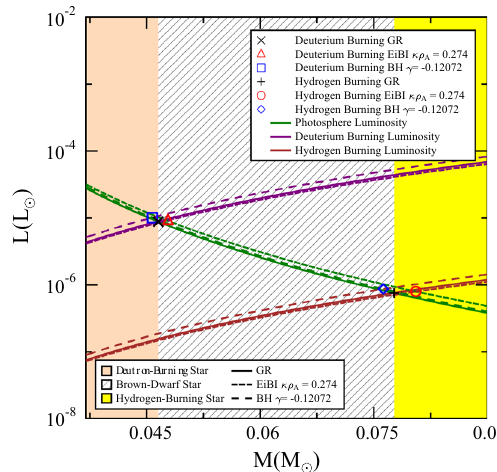
Fig. 4 Nuclear and photosphere luminosities are utilized to categorize the BD area predicted by the BH and EiBI theories using κρ A = 0 . 274 and γ = − 0 . 1207. Those of GR with their corresponding hydrogen- and deuterium-limiting mass boundaries are provided for